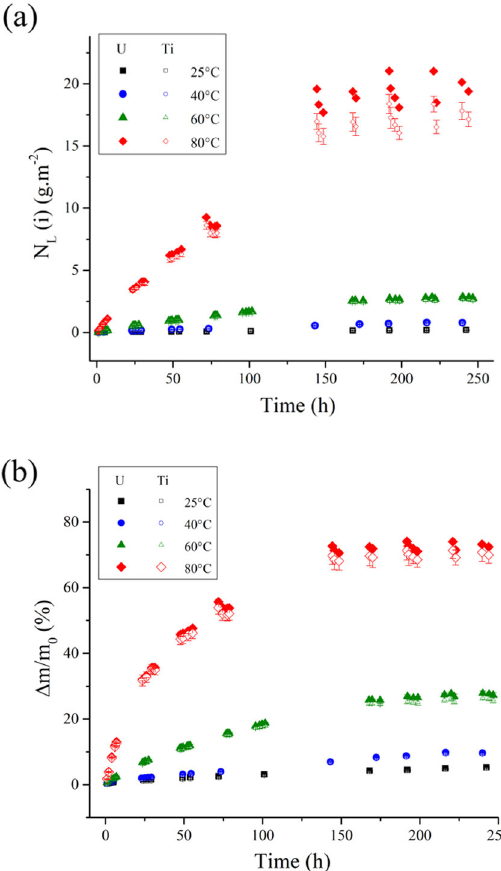
Fig. 4 Dissolution of brannerite in 2 mol/L H 2 SO 4 with 2.8 g/L of Fe (III). Evolution of the normalized weight losses N L (i) (g/m 2 ) ( a ) and of the relative mass losses Δ m / m 0 (%) ( b ) obtained during the dissolution of synthetic brannerite samples in 2 mol/L H 2 SO 4 solution containing 2.8 g/L of Fe(III) for various temperatures.